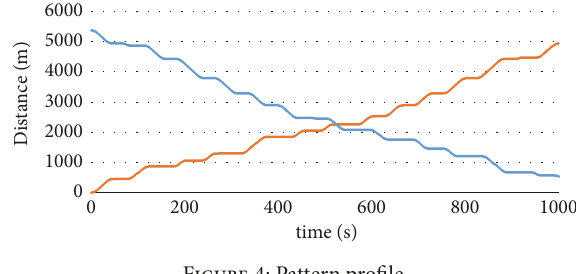
Figure 4: Pattern